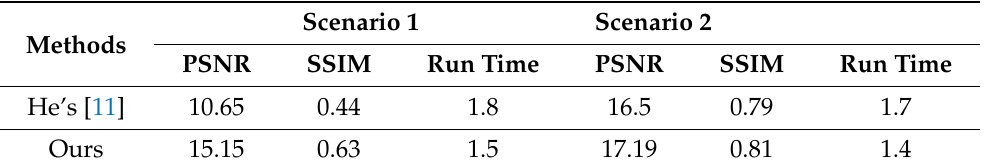
Table 1. Quantitative results of He’s algorithm [11] and our proposed methods in the images of Figure